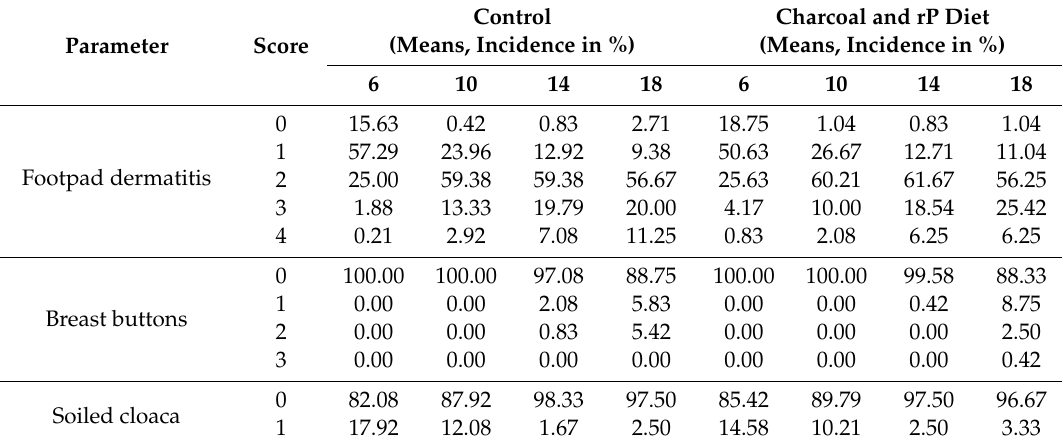
Table 8. Results of the scoring of health parameters of the BUT6 turkey toms in control and charcoal + protein-reduced (rP) diet groups of Experiment 2, percentage of each score per parameter (%); ( n = 3 farms, n = 6 batches, n = 960 turkeys per